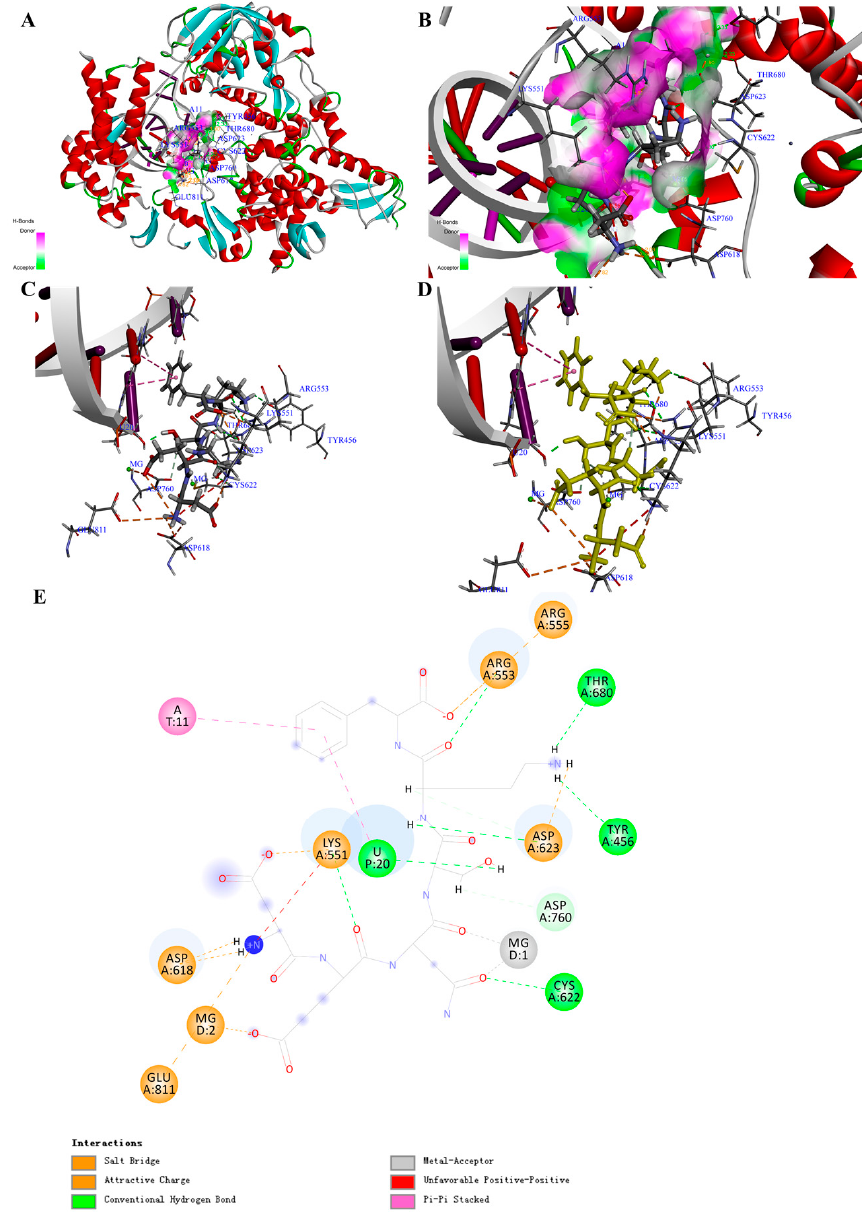
Figure 3. Structure of the COVID-19 virus RNA-dependent RNA polymerase (COVID-19 virus RdRp) complex containing peptide (PR1) and its binding modes. ( A ) Three-dimensional (3D) structure of the COVID-19 virus RdRp complex containing PR1. For clarity, the interface receptor amino acids residues are shown in thin stick style and PR1 is shown in thick stick style. COVID-19 virus RdRp is downloaded from PDB (No. 7BV2) and generated in DS software with deleting the RMP and POP ligands. Different colors represent different secondary structures: red is α -helix, blue is β -fold, green is β -turn, white is random coil. PR1 is the peptides, Asp-Glu-Asn-Ser-Lys-Phe, with the highest total interaction energy to COVID-19 virus RdRp. ( B ) Enlarged view of the interface in COVID-19 virus RdRp complex containing PR1. ( C , D ) Binding site between PR1 and COVID-19 virus RdRp and the main interaction residues. Dashed lines with different colors represent the non-covalent interaction between PR1 and COVID-19 virus RdRp. ( E ) Two-dimensional (2D) representation of interactions between PR1 and amino acid residues of COVID-19 virus RdRp.